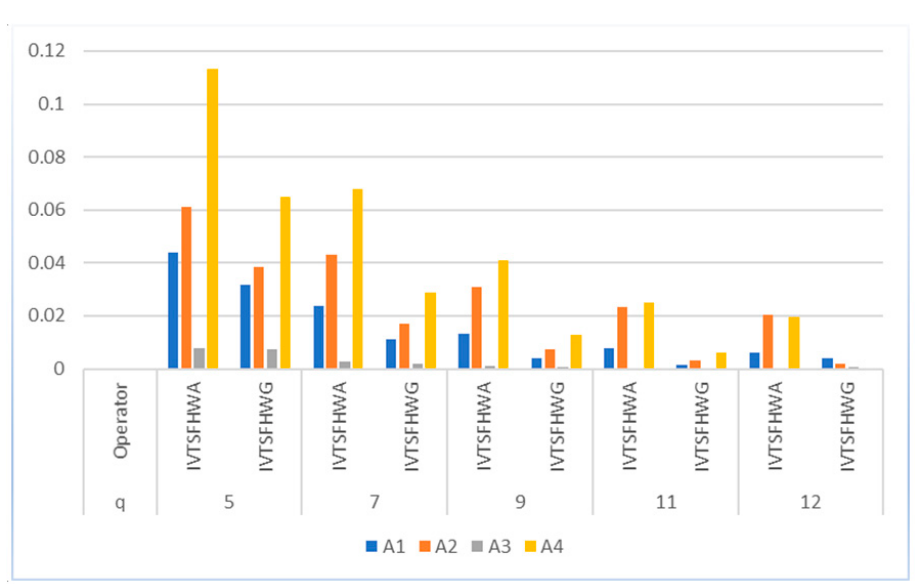
Figure 3 . Graphical view of Table 5. Figure 3. Graphical view of Table